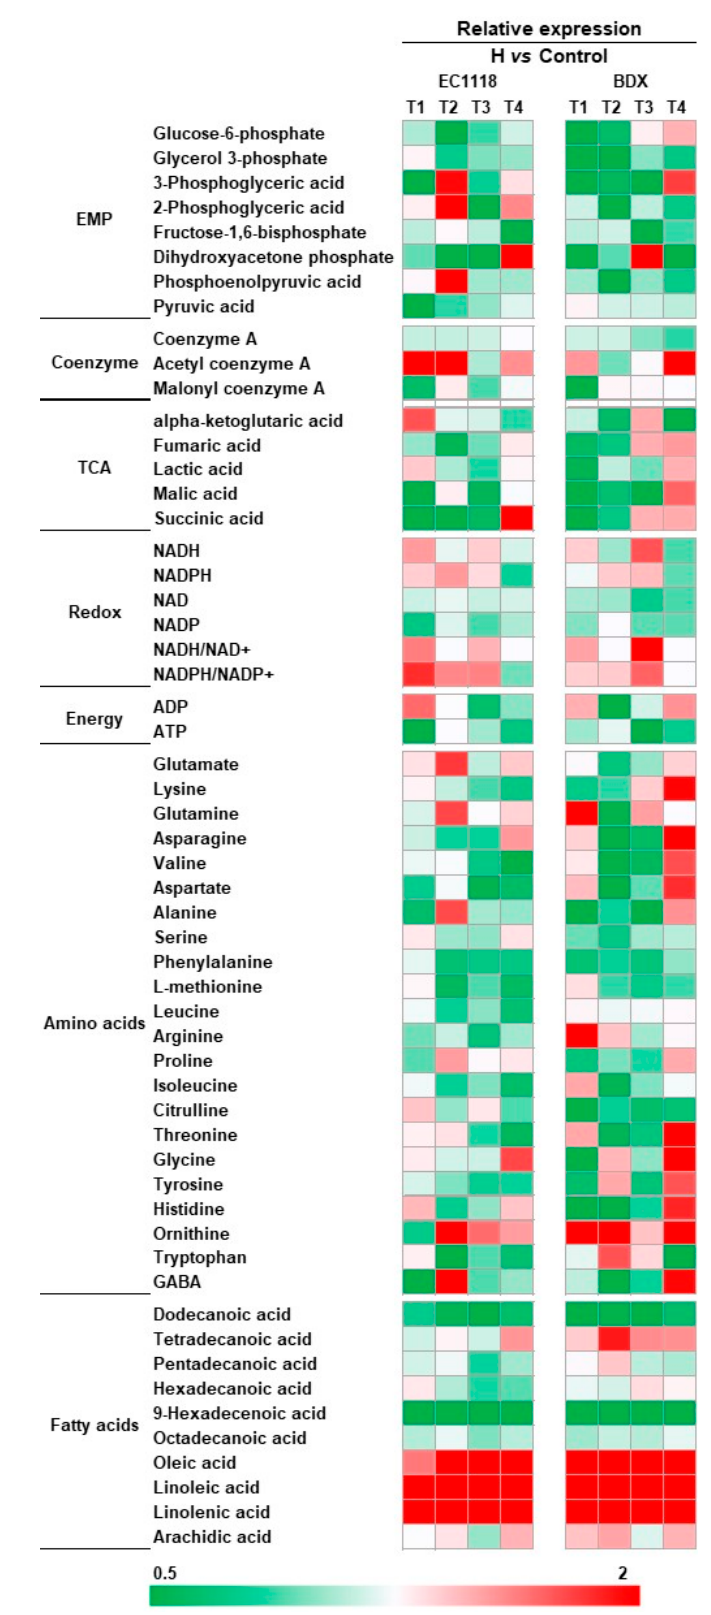
Figure 3. The comparison of intracellular metabolites produced by EC1118 and BDX strains in high-UFAs addition vs. the control wines fermentation. T1, T2, T3, and T4 represent the mid-exponential phase, the early-stationary phase, the mid-stationary phase, and the end of fermentation, respectively.